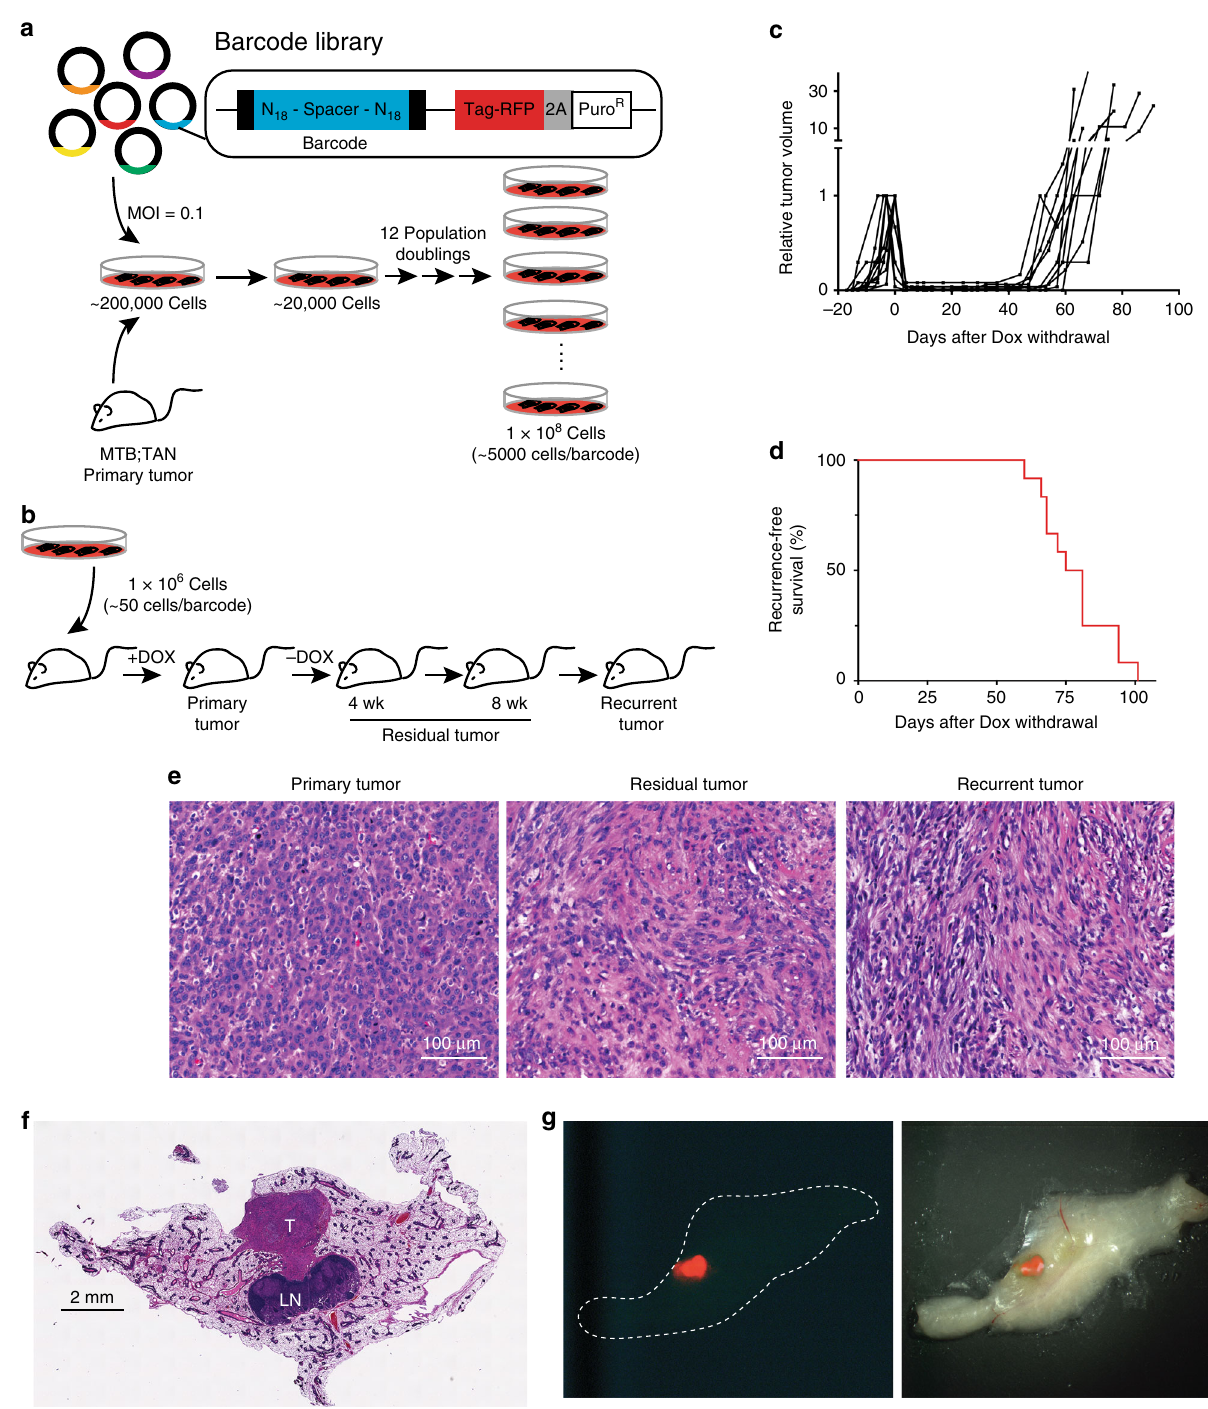
Fig. 1 Cellular barcoding to track clonal dynamics during tumor regression, residual disease, and recurrence. a Schematic of cellular barcoding strategy. Primary Her2-driven mouse mammary tumors were digested, cultured with Dox, and 200,000 cells were infected at low MOI (0.1) with a lentiviral barcode library comprising ~60 million unique barcodes. Following selection for transduced cells, the population was expanded to yield a population of